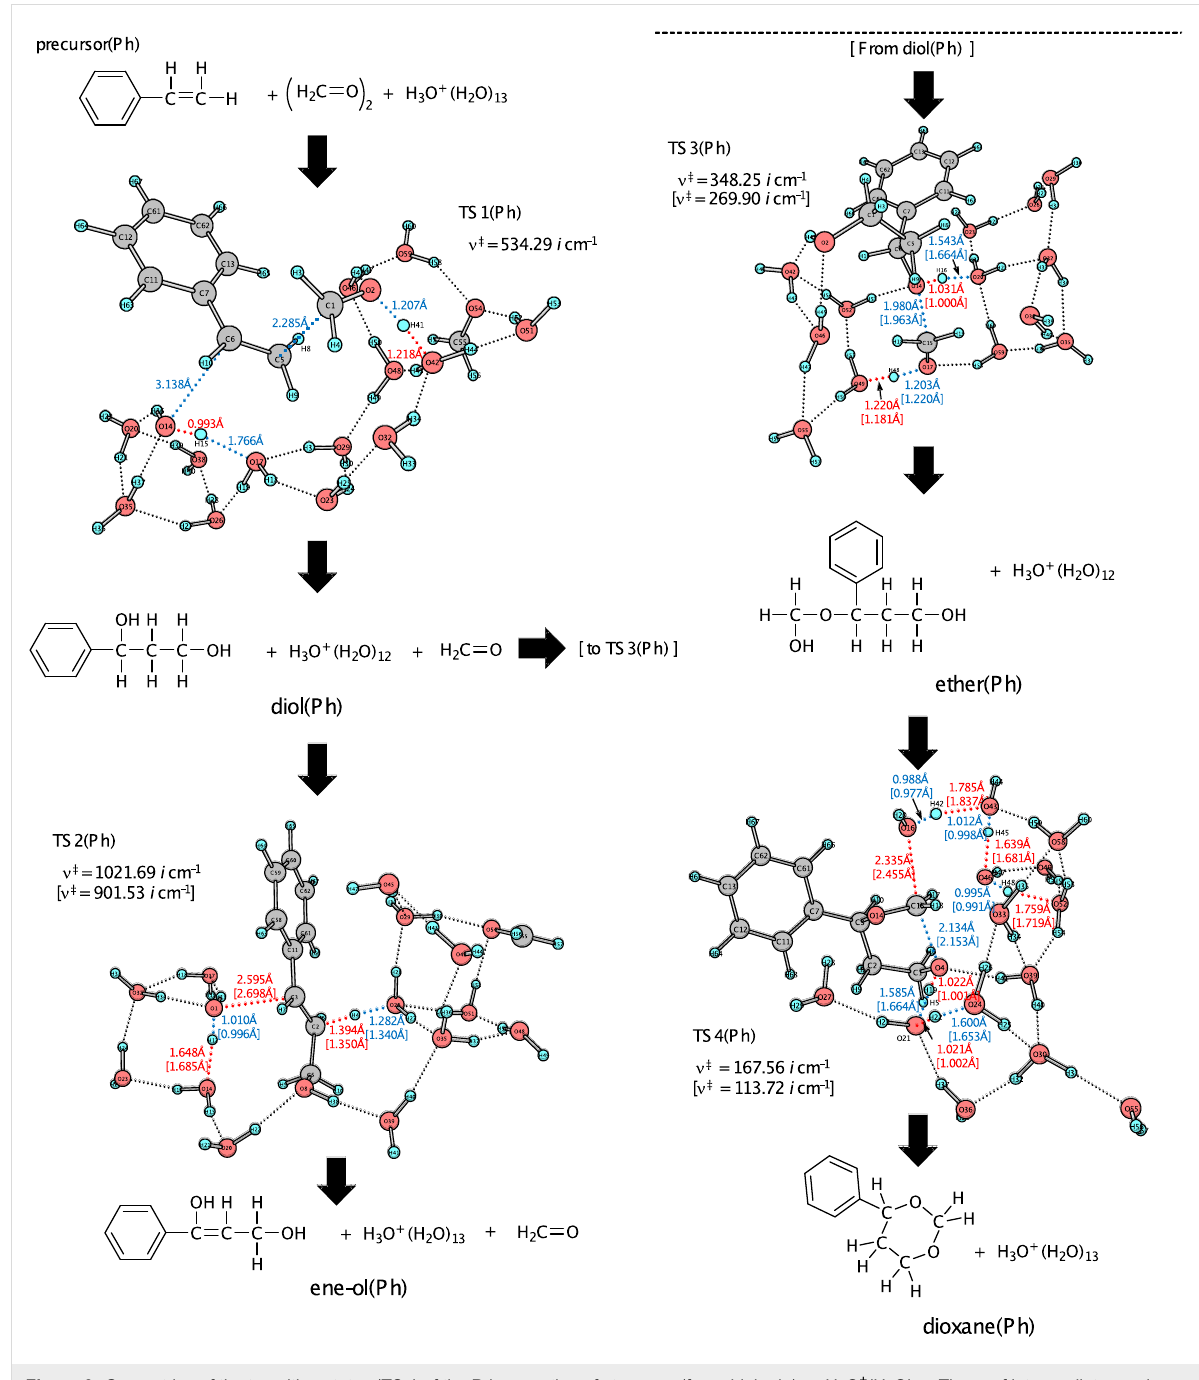
Figure 3: Geometries of the transition states (TSs) of the Prins reaction of styrene + (formaldehyde) 2 + H 3 O + (H 2 O) 13 . Those of intermediates and products are exhibited in Figure S3 of Supporting Information File 1. "(Ph)" denotes the styrene (R–HC=CH 2 , R = phenyl) reaction. The geometry of TS1(Ph) by B3LYP/6-311+G(d,p) is shown in Figure S4 as TS1’(Ph).